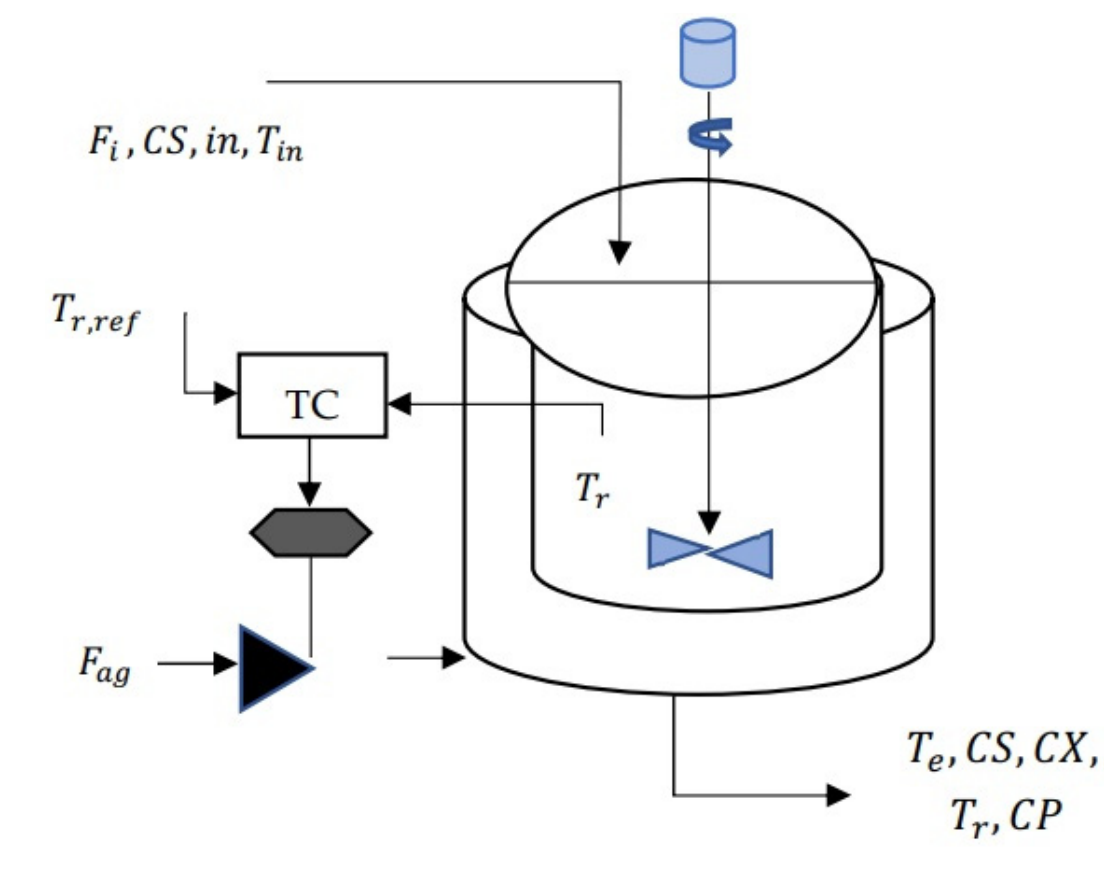
Figure 5. Flow diagram of a bioreactor tank [54].